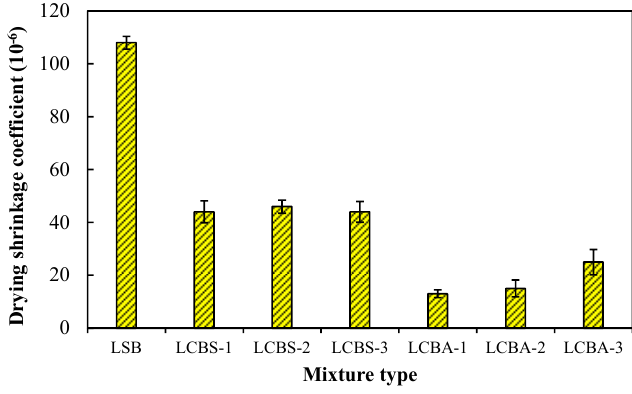
Figure 8. Drying shrinkage coefficient of stabilized boron waste mixture. Table 7. Mechanical properties of stabilized boron waste mixtures.